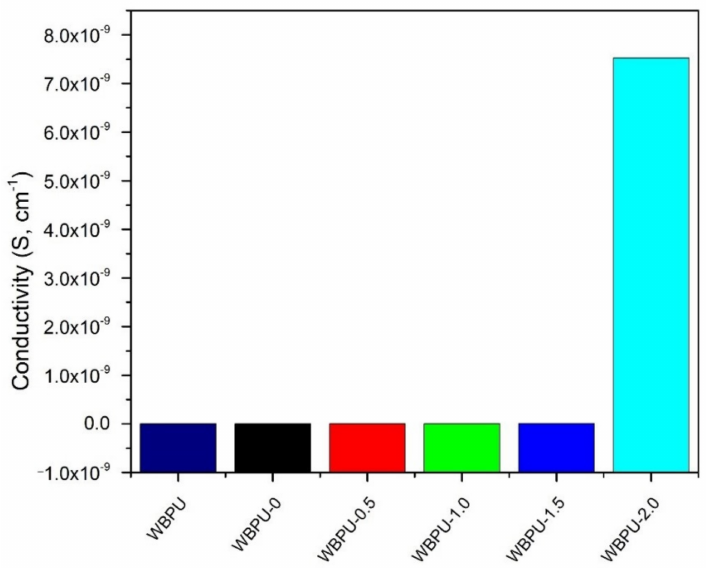
Figure 10. Conductivity profile of all nanocomposite